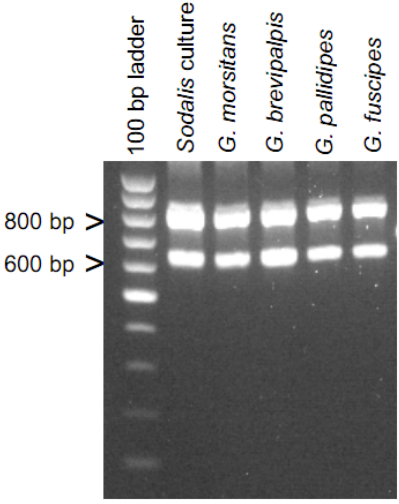
Figure S2. Specificity of ITS primers for Sodalis . The ITSfor and ITSrev primers do not amplify the corresponding Wigglesworthia ITSglu. Both Sodalis ITS1 variants were amplified; the 646 bp amplicon contains the 492 bp ITSglu, while the 825 bp amplicon contains the 671 bp ITSala,ile. Tsetse host species are